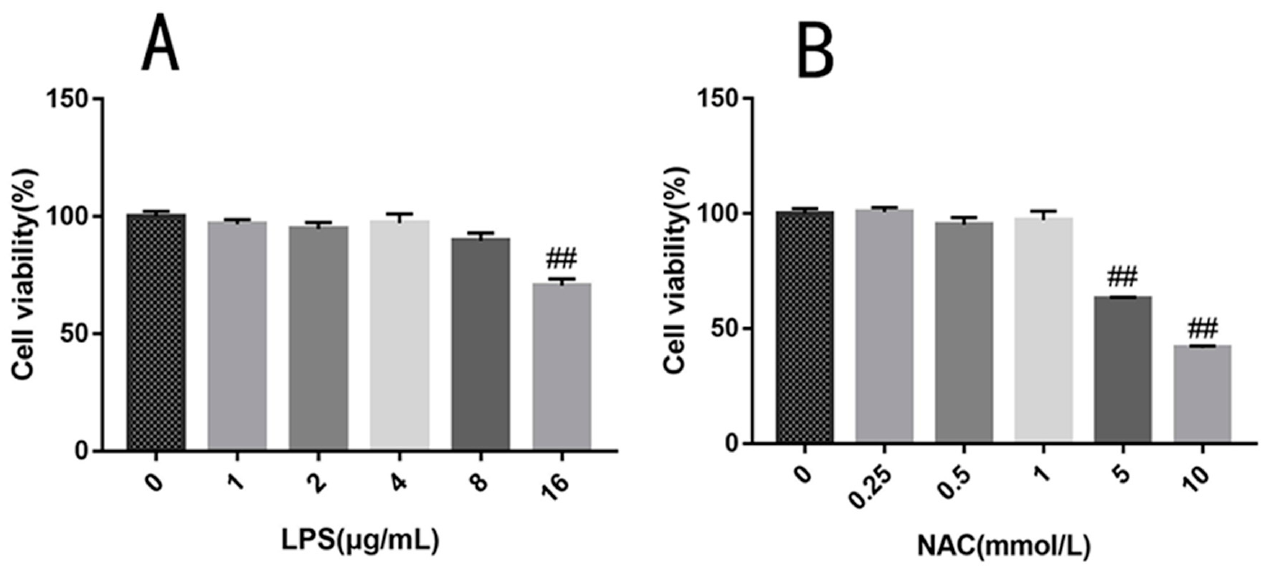
Figure 2. Evaluation of cell viability following different concentrations of LPS and NAC treatment. Cells were exposed to different concentrations of ( A ) LPS (1, 2, 4, 8, or 16 µ g/mL) and ( B ) NAC (0, 0.25, 0.5, 1, 5, 10 mmol/L) for 24 h. All results are expressed as the means ± SEM. ## indicates p < 0.01.